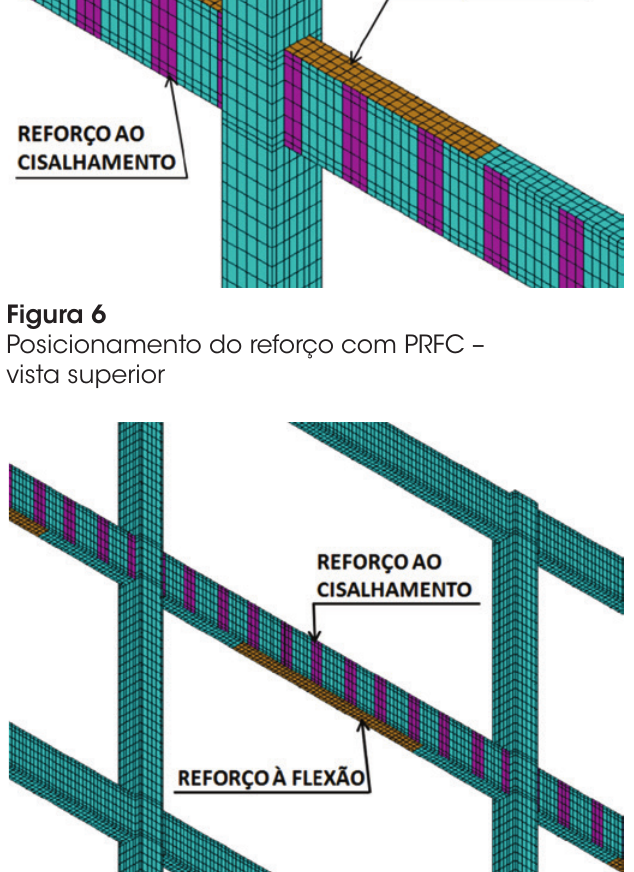
Figura 8 Vista das armaduras dos elementos modelados na ligação viga-pilar